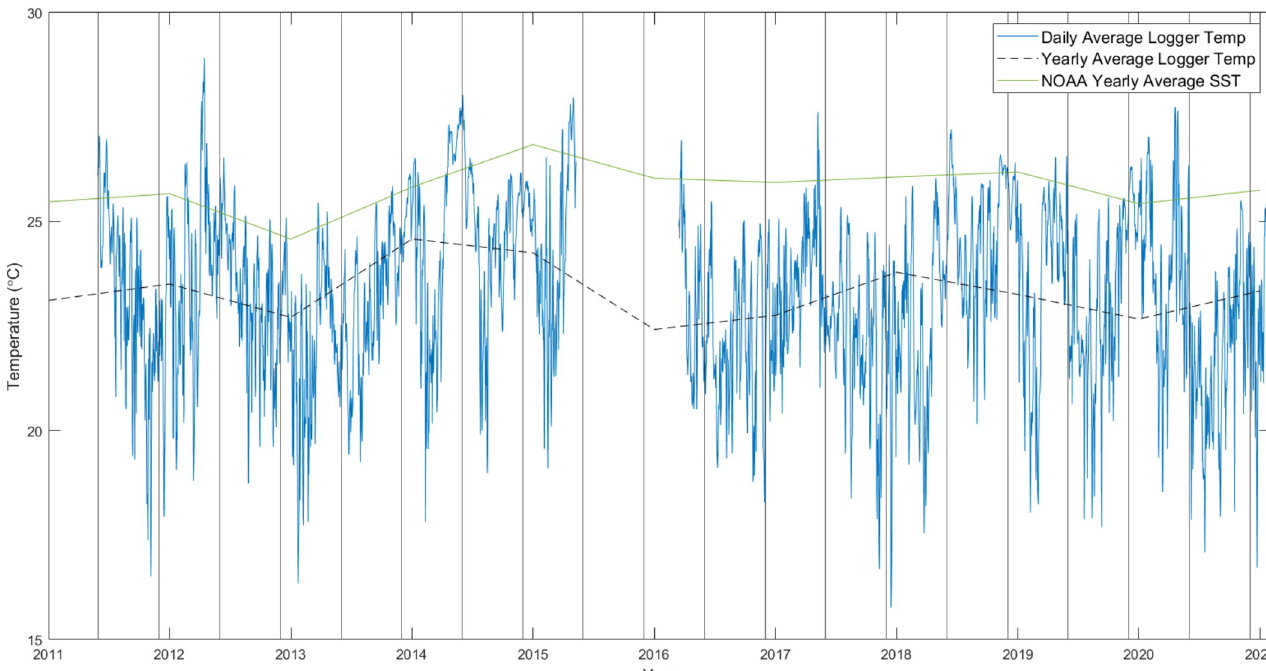
Fig 4. Yearly and daily temperature average from Wolf Island. Graph comparing the yearly (black dashed) and daily (blue) average temperature data from loggers at 20 m depth at the anchorage point of Wolf Island to the yearly average of NOAA SST data (NOAA, 2000) within the area of 1˚, 2˚ latitude, and -92.5˚, -91.5˚ longitude